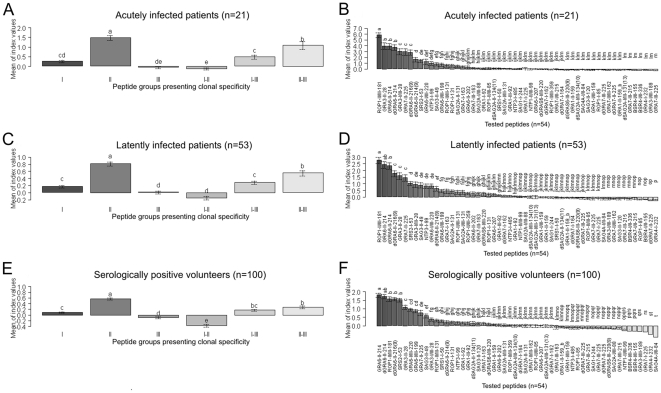
Strongest reaction intensities were recorded for clonal type II specific peptides.To evaluate the intensities (MSIVs) by which single peptides as well as peptide cohorts (I, II, III, I–II, I–III, or II–III) were recognized by T. gondii seropositive patient and volunteer groups, ANOVA and the Least Significant Difference (LSD)-Post-Hoc-Test were performed. Whiskers in barplots represent 95% confidence intervals of the means of MSIVs. The differences between the means of MSIVs for single peptides or peptide cohorts within tested groups were regarded as statistically significant, when the differences were equal or higher than the LSD values. Different letters above the whiskers indicate significant differences between the mean intensities in the Post-Hoc-LSD test. Means of MSIVs for each peptide cohort are presented in (A) for the acutely infected patient group (LSD>0.36, p-value<0.05); in (C) for the latently infected patient group (LSD>0.16, p-value<0.05); and in (E) for the seropositive volunteer group (LSD>0.10, p-value<0.05). Means of MSIVs for each single peptide are presented in (B) within the acutely infected patient group (LSD>0.67, p-value<0.05); in (D) within the latently infected patient group (LSD>0.36, p-value<0.05); and in (F) within the seropositive volunteer group (LSD>0.24, p-value<0.05).